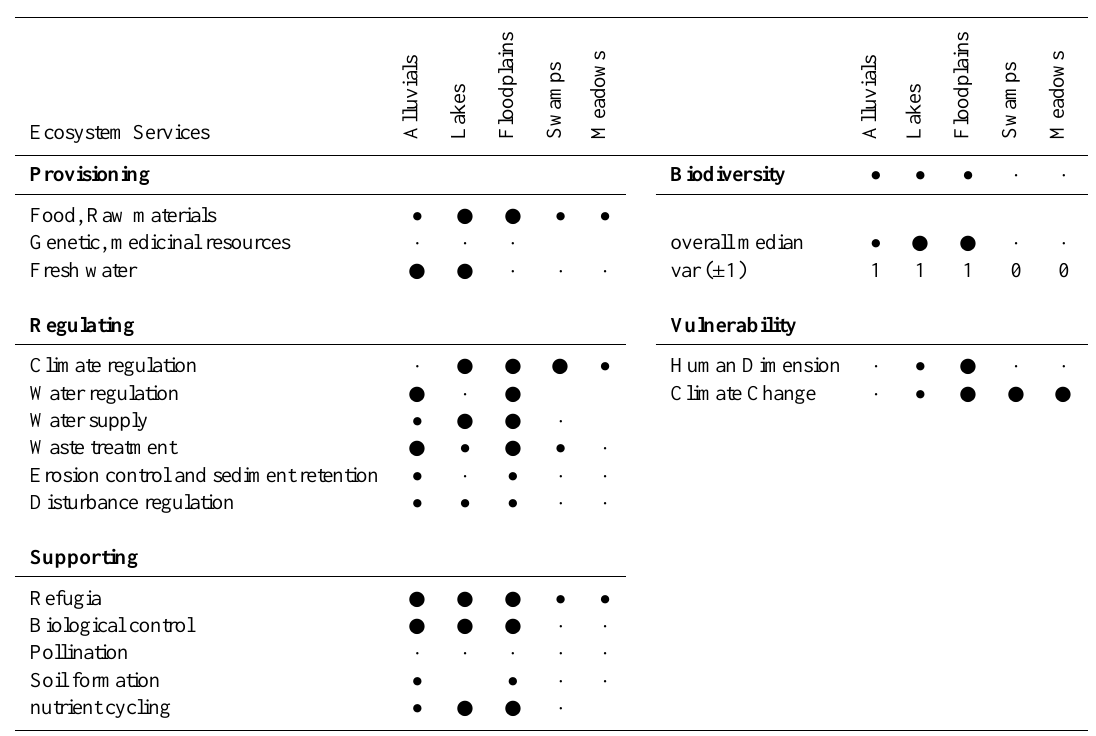
Table 8. Lhasa Sub-catchment: Ecosystem Services, Biodiversity and Vulnerability Assessment: Relative magnitude [low ( · ) – medium ( • ) – high ( )]. Weighting follows Millenium Ecosystem Assessment